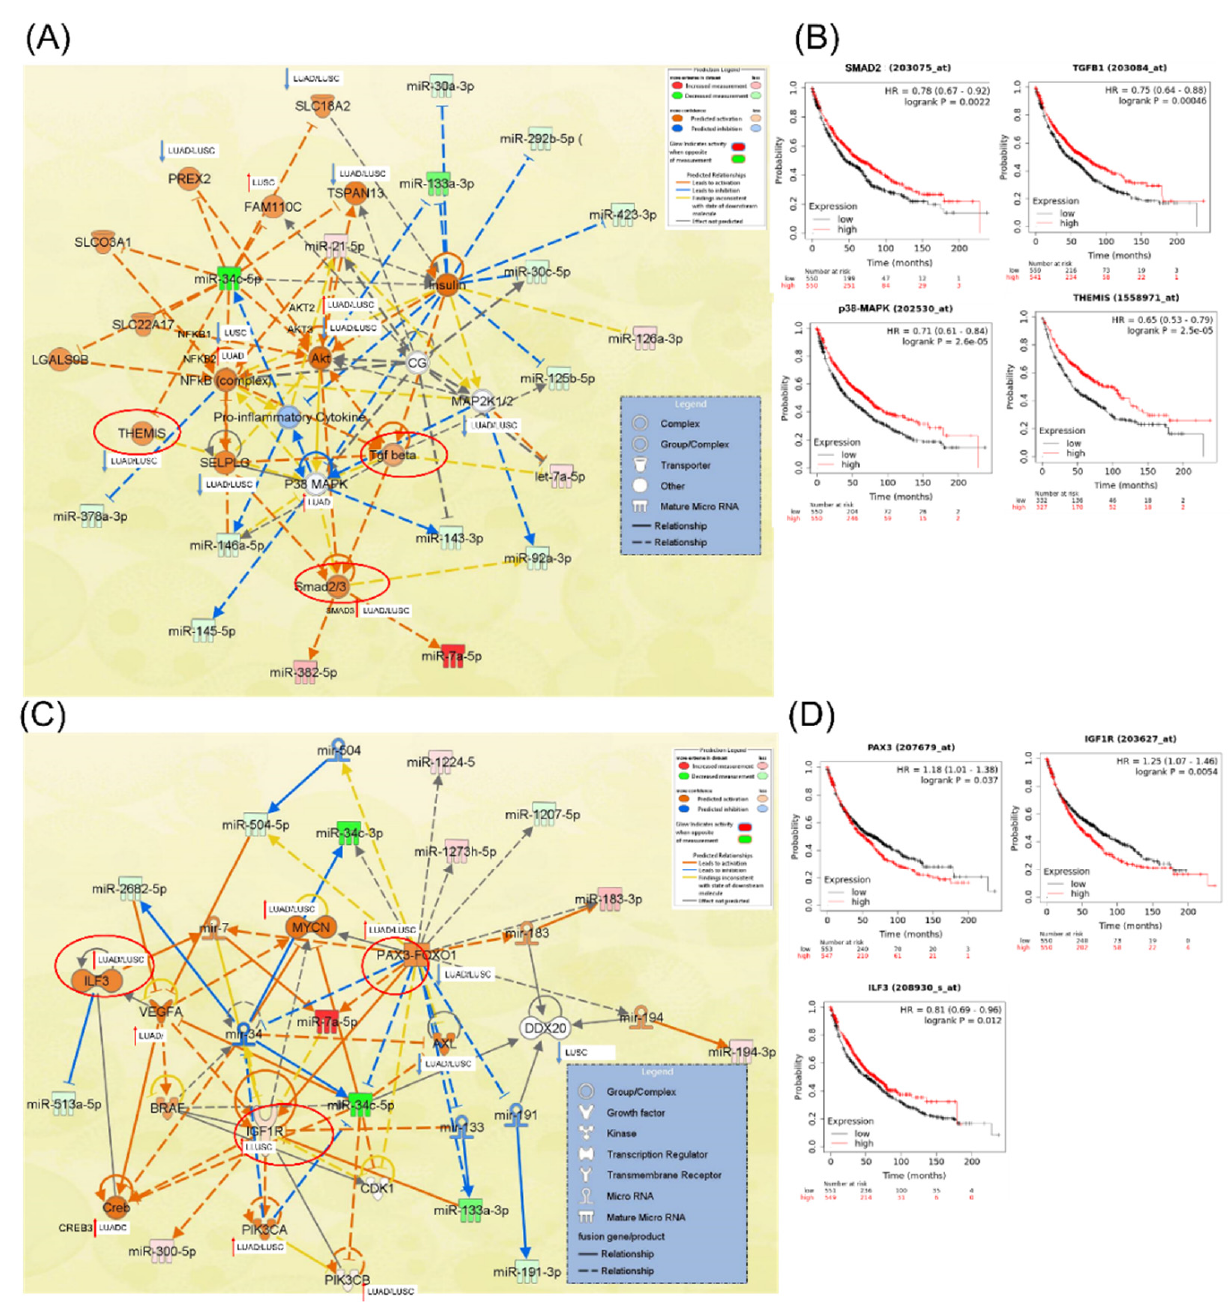
Figure 4. IPA network for altered miRNAs in UMPh patient cohort. ( A ) Network related to cancer, organismal injury, abnormalities, and reproductive system disease; ↑ upregulated genes, ↓ downregulated genes in LUAD or LUSC according to UALCAN (http://ualcan.path.uab.edu). ( B ) Genes from the network correlated with overall survival in NSCLC, generated using Kaplan–Meier plotter online platform (https://kmplot.com/analysis/ accessed on 23 October 2022). ( C ) Network related to cellular movement, development, growth, and proliferation. ( D ) Genes from the network correlated with overall survival in NSCLC, generated using Kaplan–Meier plotter online platform (https://kmplot.com/analysis/ accessed on 23 October 2022).